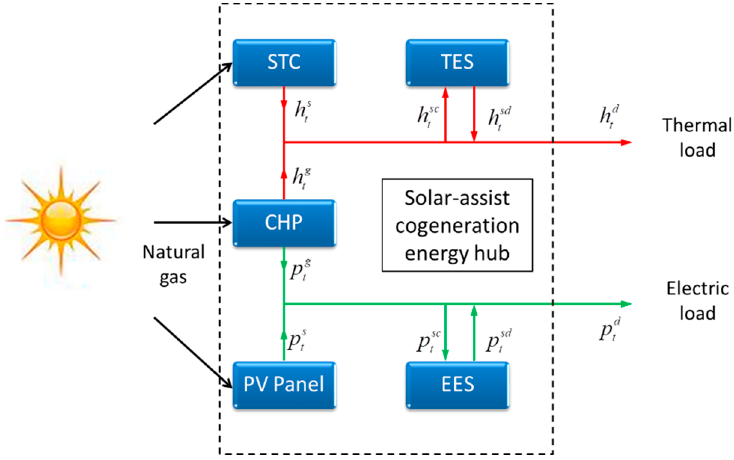
Figure 1. Configuration of the solar-assist co-generation energy hub.